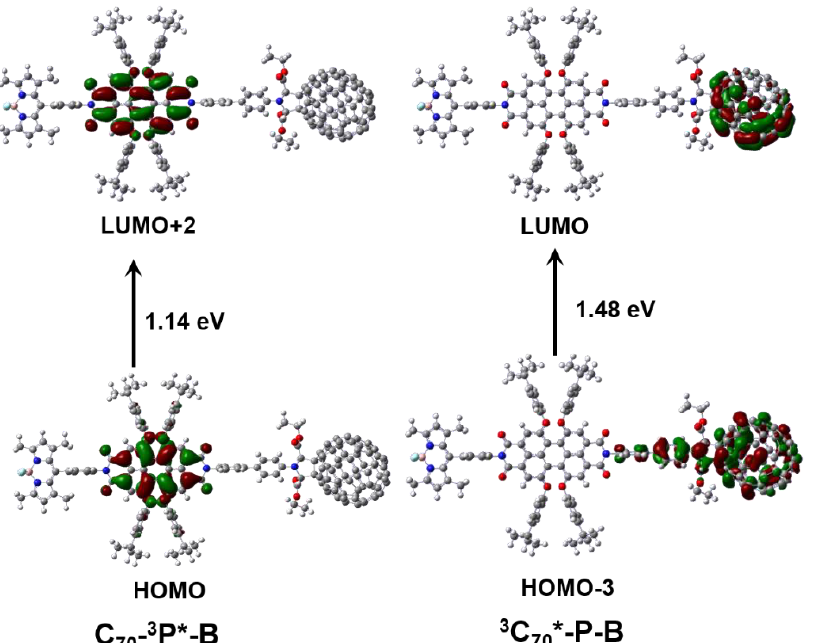
Figure 6. Frontier molecular orbitals involved in the triplet excited states of the C 70 -P-B , in which the vertical excitation energy is labelled. The calculations were performed at the TD-DFT//B3LYP/6- 31G(d) based on the DFT//B3LYP/6-31G(d) optimized ground state geometries using toluene as the solvent.